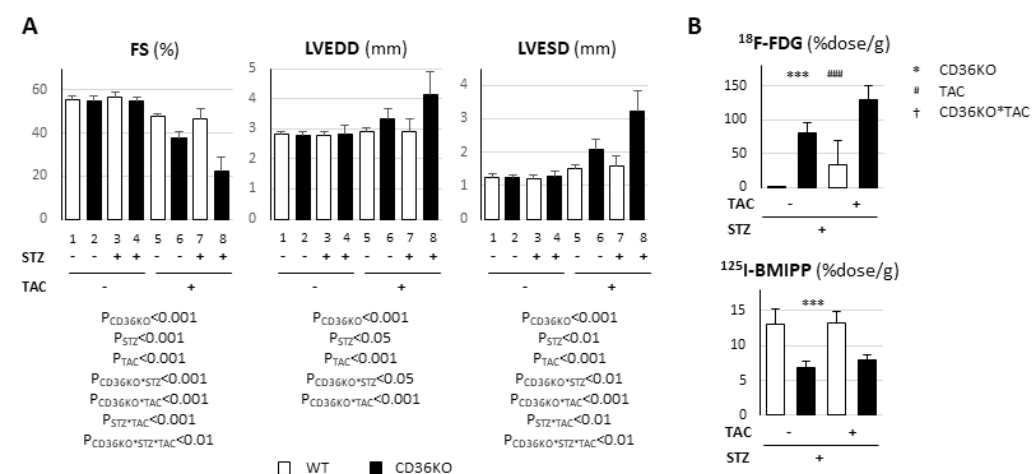
Figure 6. Cardiac contractile dysfunction was synergistically enhanced by STZ and TAC in CD36KO mice. Four weeks after STZ i.p., mice were subjected to TAC. ( A ) Cardiac contractile function was estimated by echocardiography seven days after TAC ( n = 5–9). ( B ) Uptake of 18 F-FDG and 125 I-BMIPP was estimated seven days after TAC ( n = 6–7). *** p < 0.001; main effect for genotype. ### p < 0.001; main effect for STZ treatment.